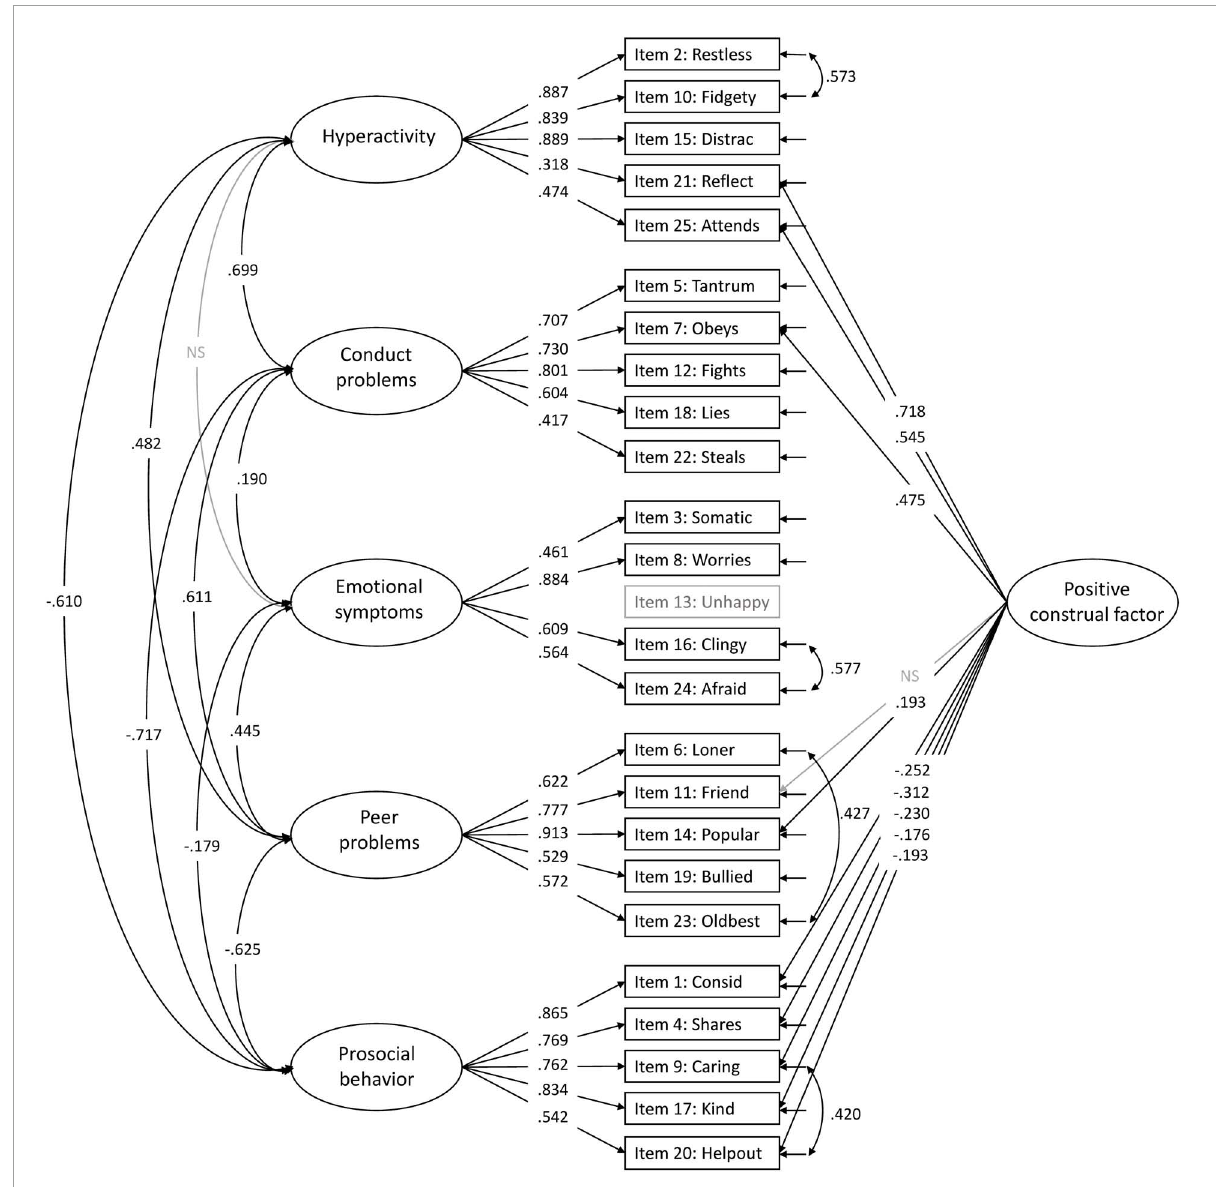
FIGURE8 Accepted five-factor model with a positive construal method factor (Model 4). All paths are significant unless marked non significant (NS). Item 13 is not included in the confirmatory factor analysis